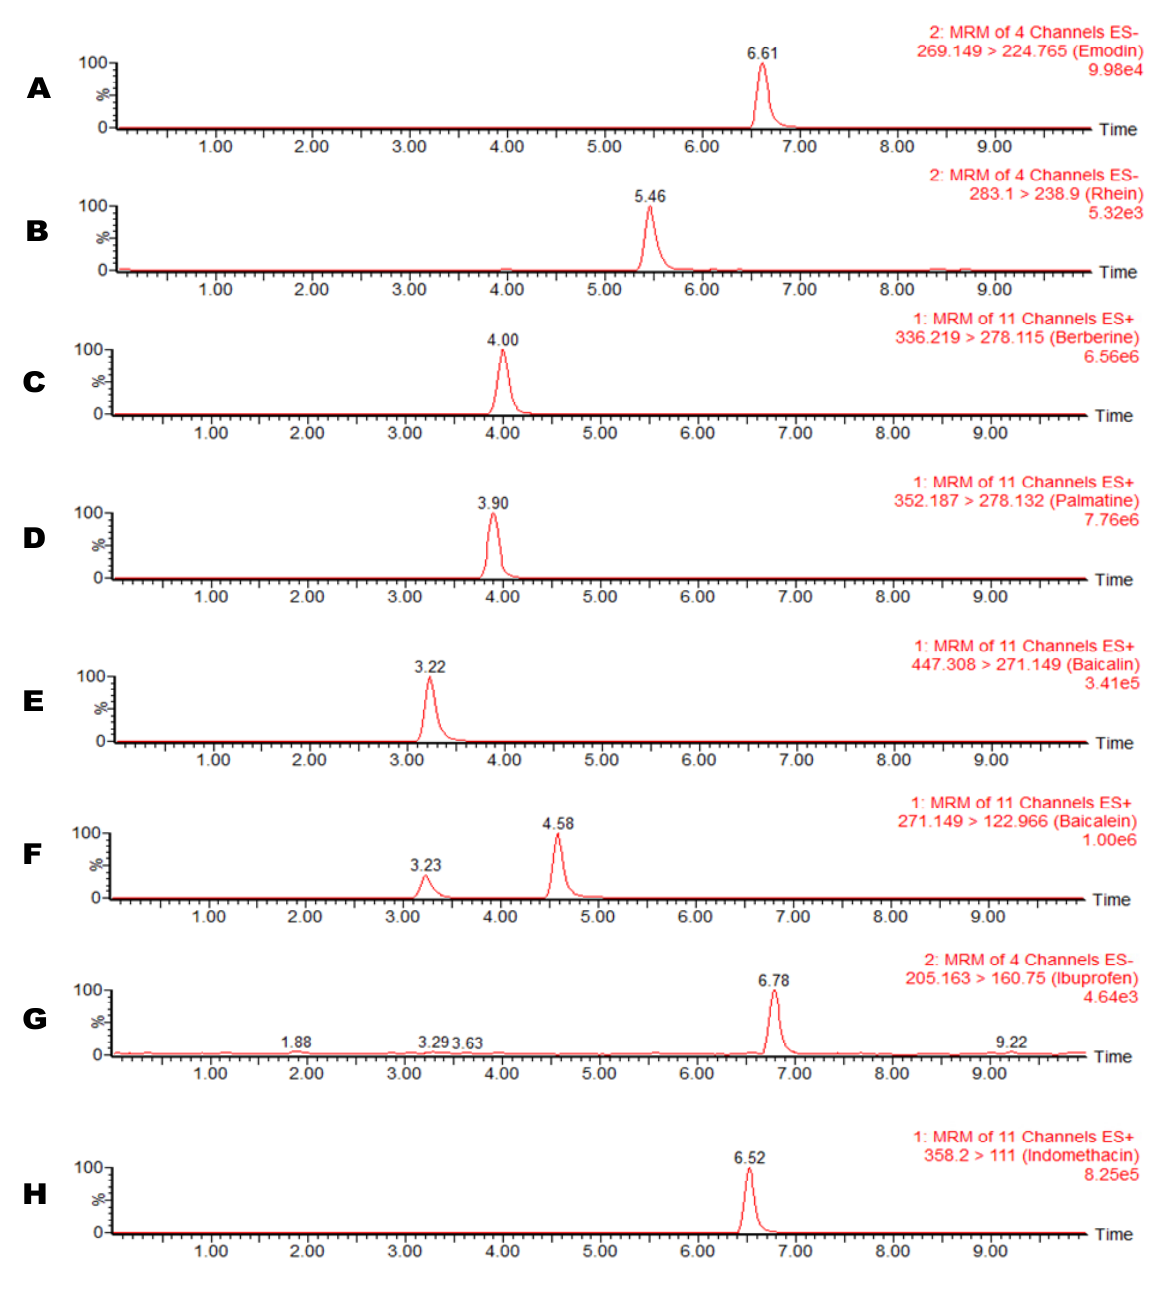
Figure 2. Representative UPLC-MS/MS chromatograms of ( A ) emodin; ( B )